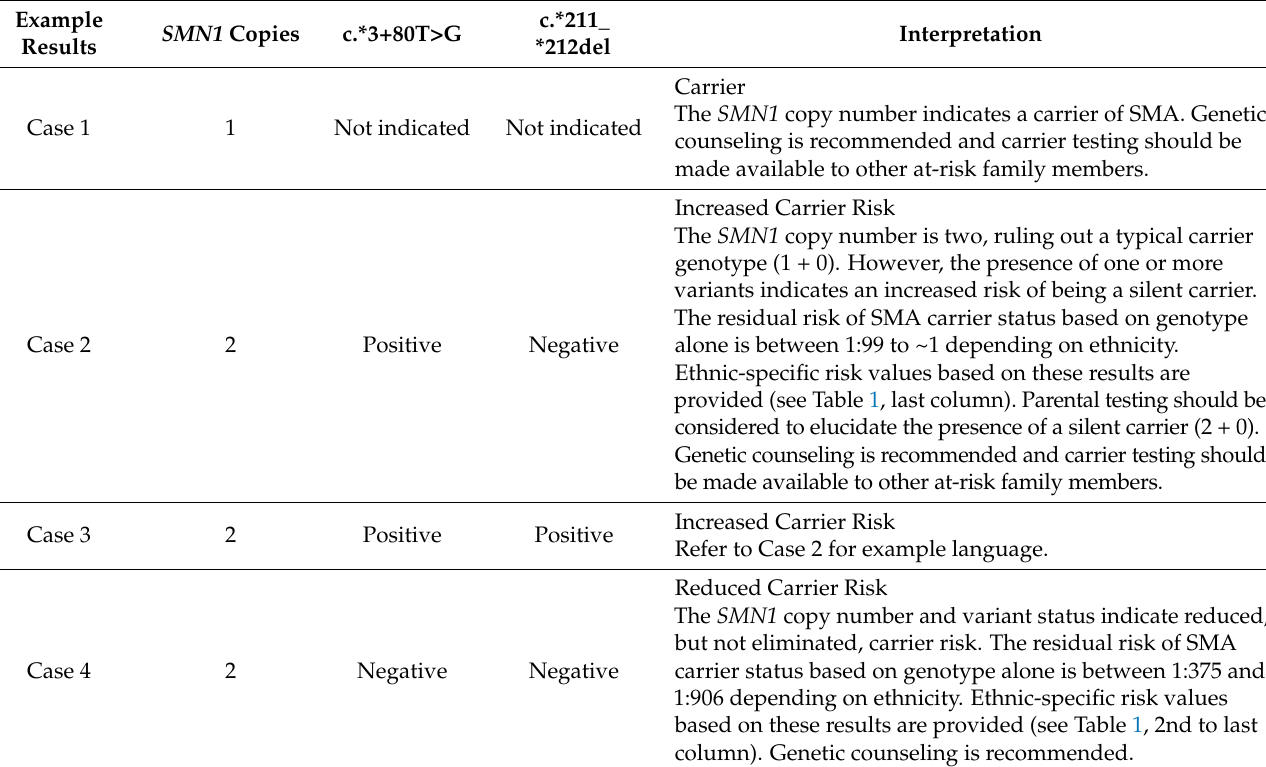
Table 2. Carrier Results Interpretation Examples. The examples provided here are interpretations based on relevant guidelines [8,11] and literature [10,11,18,25,29]. When interpreting and presenting results, all relevant local guidelines and regulations should be